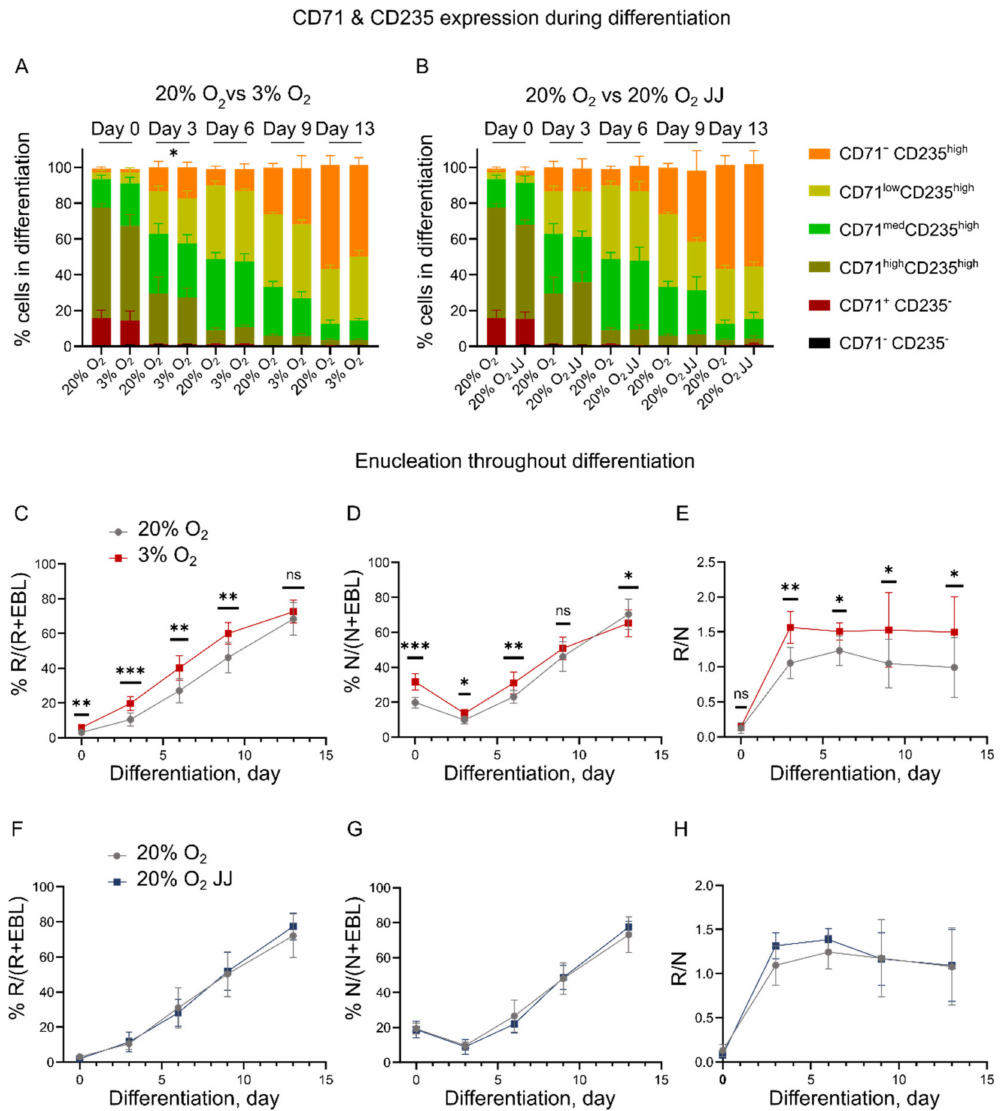
Figure 2. Erythroid marker expression and enucleation during differentiation. ( A , B ) CD71 and CD235 expression did not differ across all culture conditions, showing comparable populations. An exception is CD71–CD235 high cells, which were significantly higher at day 3 differentiation ( p = 0.05) in 3% O 2 cultures, but not on the following days, suggesting a faster differentiation that did not result in a higher number of formed reticulocytes by day 13. ( C – E ) Enucleation efficiency was evaluated by comparing the percentage of reticulocytes over the total cell number (% R/(R+EBL)) in ( C ), nucleated cells over the total cell number (% N/(N+EBL)) in ( D ) and the ratio of reticulocytes over nuclei (R/N) in ( E ). These data highlight a higher enucleation at 20% O 2 , but a better survival of the formed reticulocytes or unstable pyrenocytes at low oxygen. ( F – H ) Similarly, comparative graphs between 20% O 2 and 20% O 2 JJ cultures showed no difference either in enucleation and reticulocyte survival. ns=non-significant, * = p < 0.05, ** = p < 0.01 and *** = p <